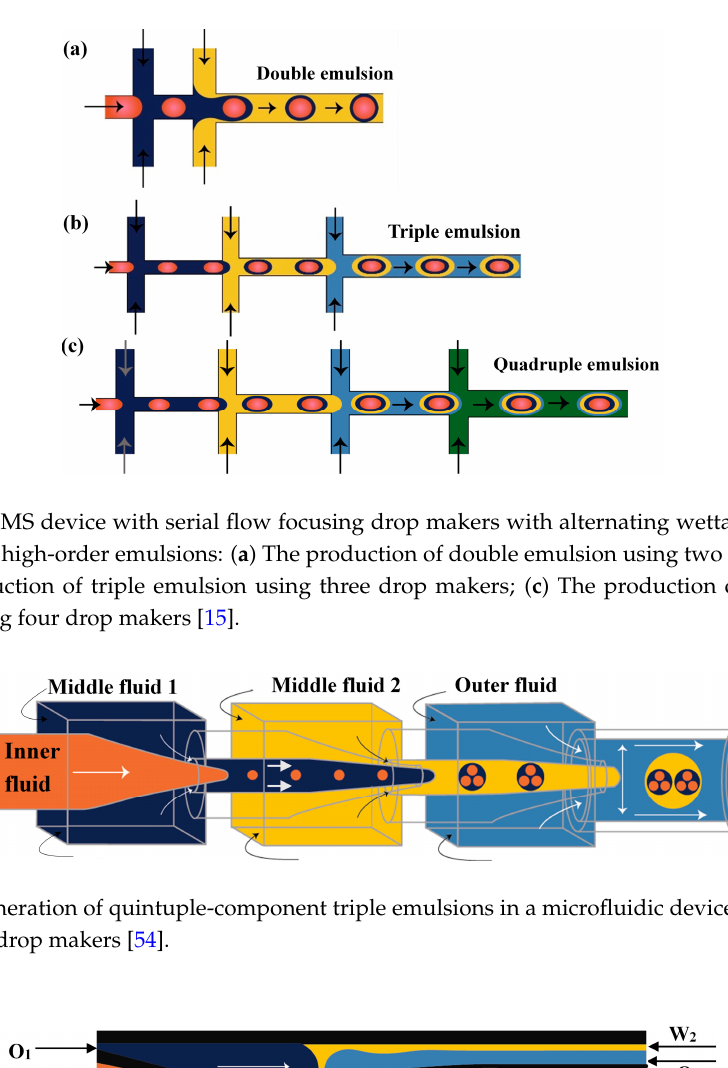
Figure 24. Generation of quintuple-component triple emulsions in a microfluidic device consisted of three co-flow drop makers [54].